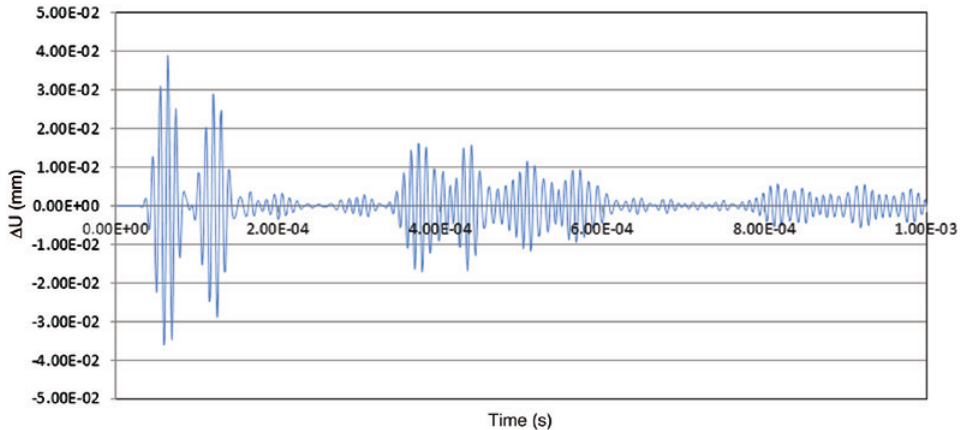
Figure 5: Strain-time history of undamaged composite beam.